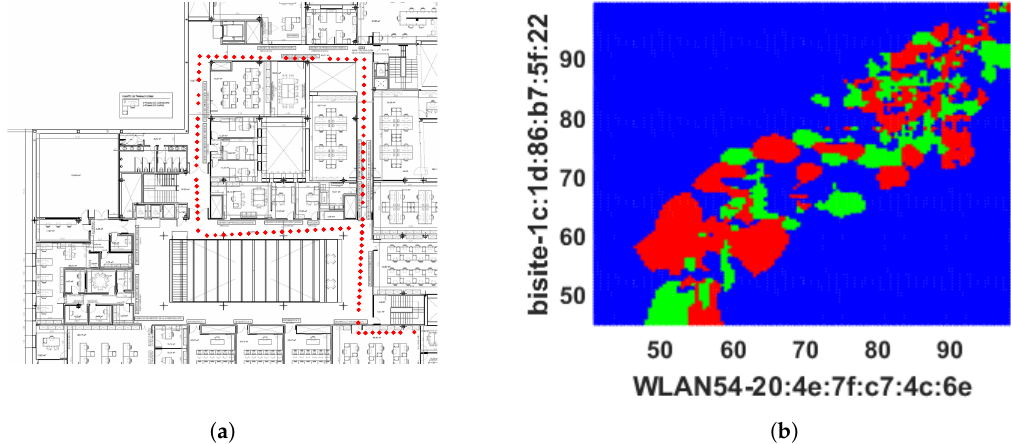
Figure 10. Prediction results obtained from 1 NN Ja classifier: ( a ) the route predicted by 1 NN Ja classifier; and ( b ) 2D decision boundary formed by 1 NN Ja